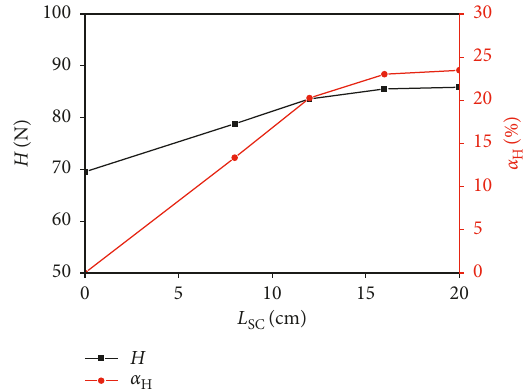
Figure 13: Effects of L SC on the ultimate horizontal bearing ca- pacity of the